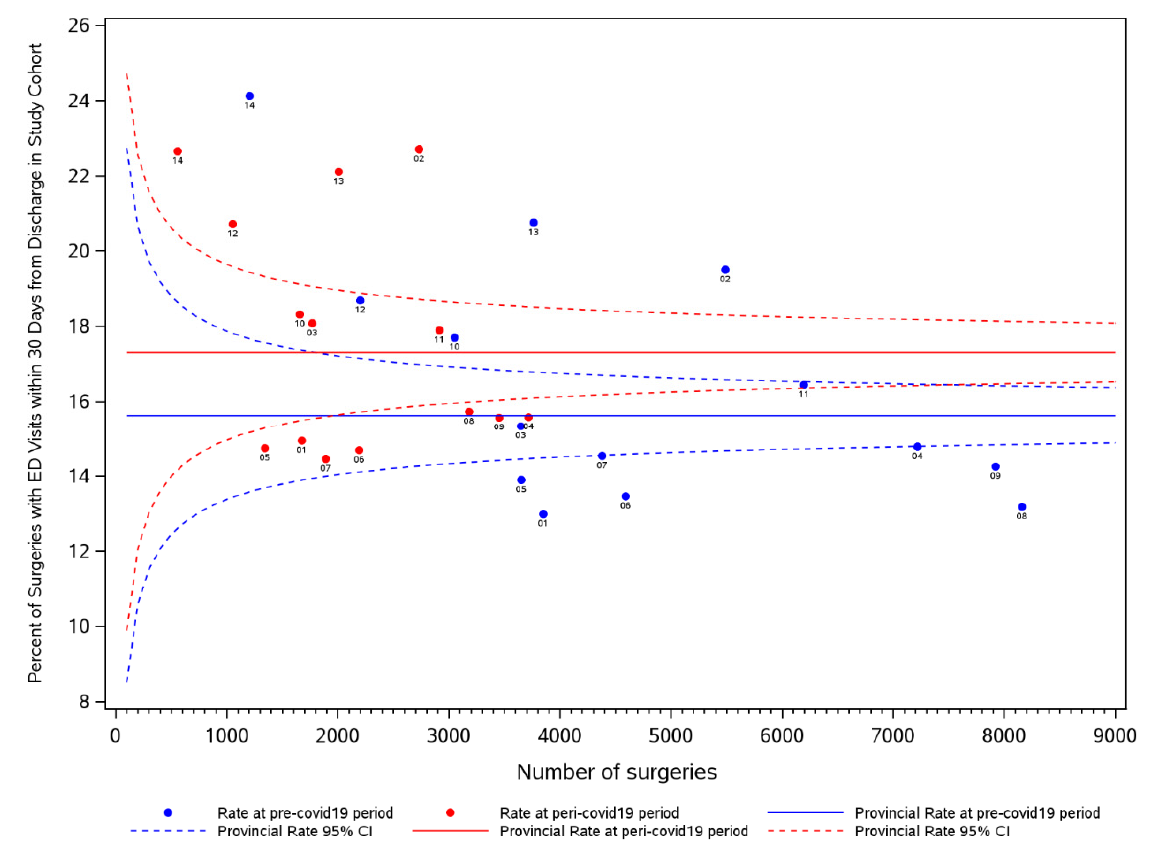
Figure 1. Funnel plot illustrating variation in ED rates following cancer-directed surgeries in the pre- and peri-periods, across LHINs. Legend : Each LHIN is represented by a dot in the funnel plot, where the x-coordinate provides the number of cancer-directed surgeries occurring in the LHIN and the y-coordinate provides the corresponding percentage that ends up in ED within 30 days following discharge. The horizontal line illustrates the average ED rate, overall, and it is surrounded by the corresponding 95% confidence limits. These limits represent the expected bound around the average proportion for varying population sizes [14].